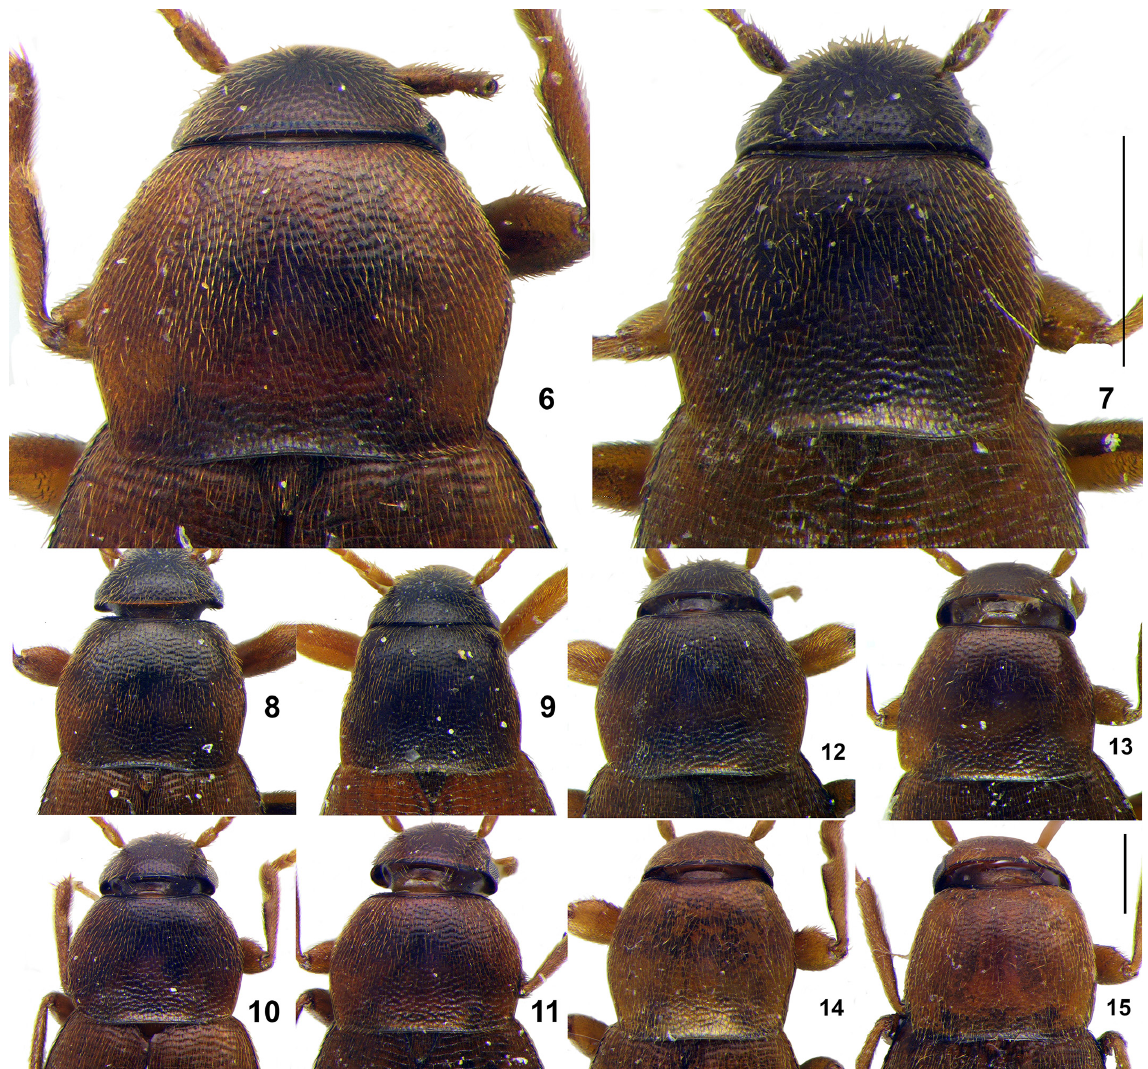
Figs 6–15. Speonemadus of the escalerai -group pronotum. 6–7 . S. algarvensis sp. nov. (Gruta do Vale Telheiro, Portugal), respectively ♂ and ♀. 8–9 . S. angusticollis (Kraatz, 1870) (Rute, Spain) respectively ♂ and ♀. 10 – 11 . S. bolivari (Jeannel, 1922) (Ardales, Spain) respectively ♂ and ♀. 12–13 . S. breuili (Jeannel, 1922) (Motillas, Spain) respectively ♂ and ♀. 14–15 . S. escalerai (Uhagón, 1898) (Jumilla, Spain) respectively ♂ and ♀. Scale bars = 1